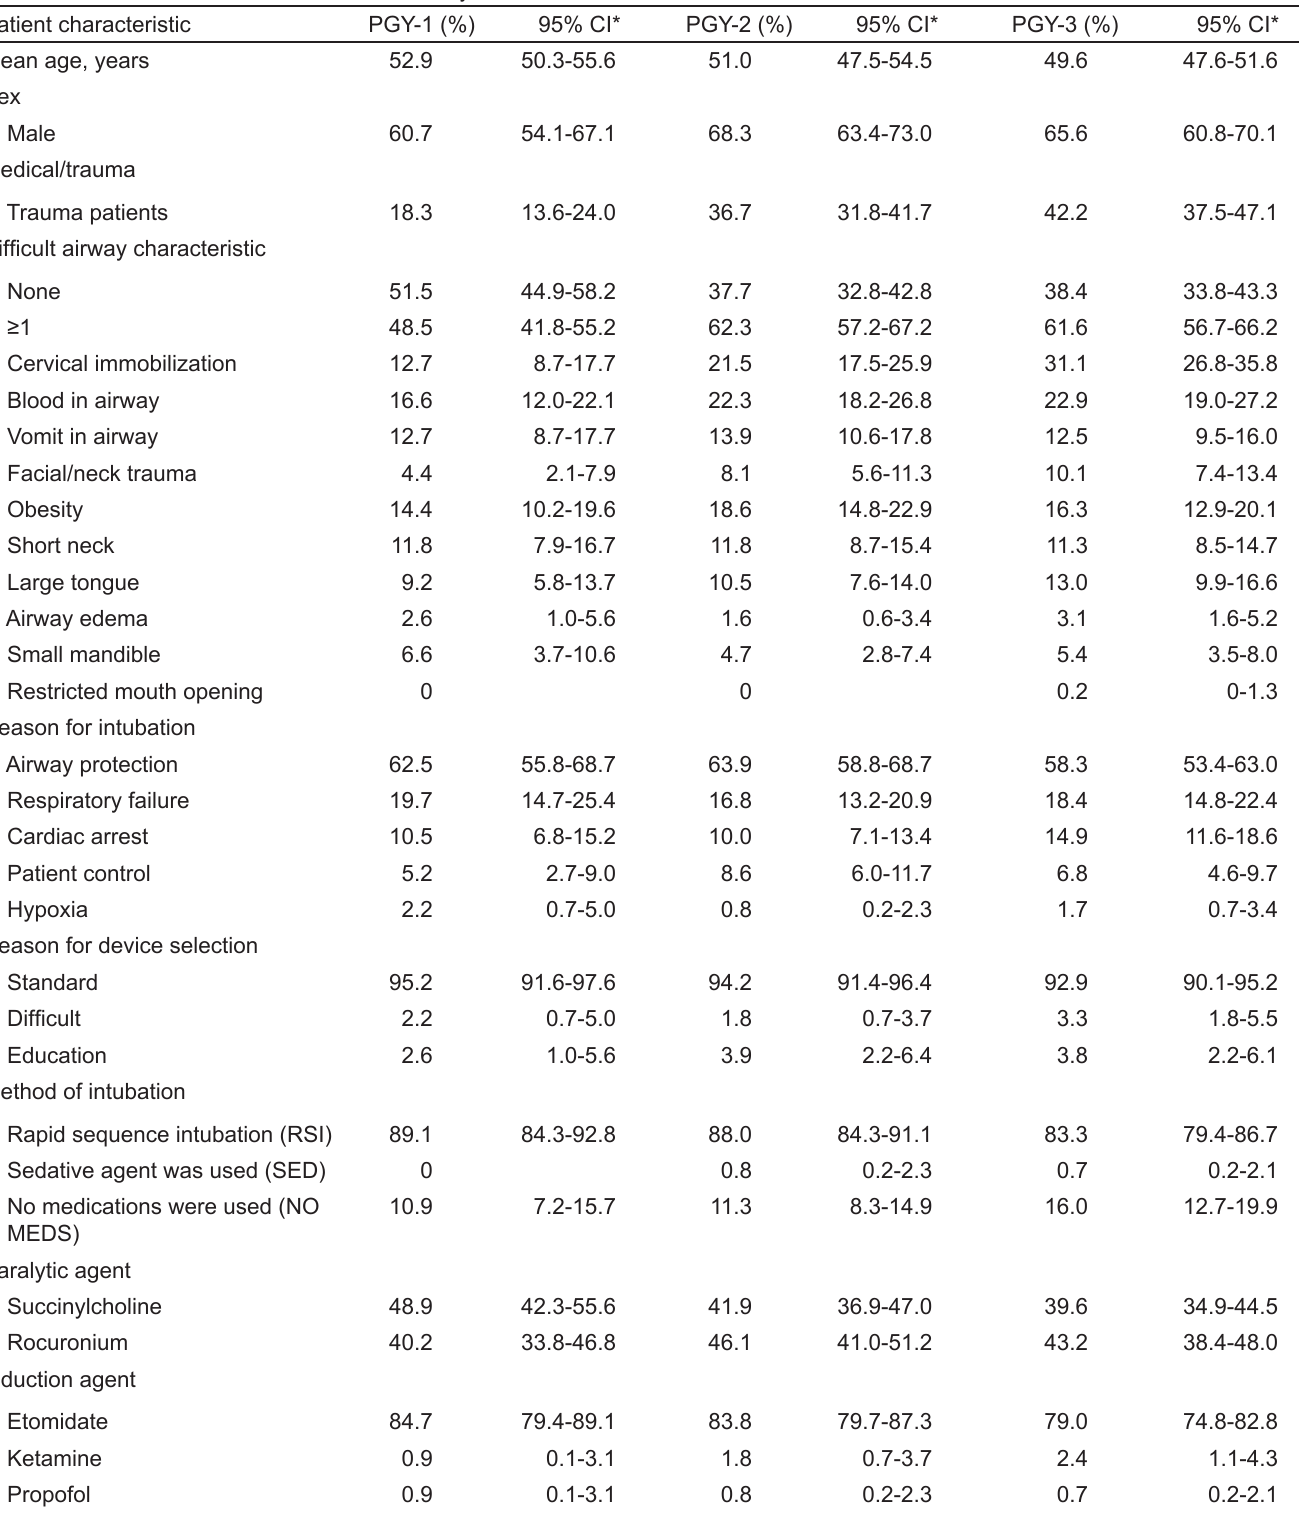
Table 1a . Patient and intubation characteristics by PGY in DL